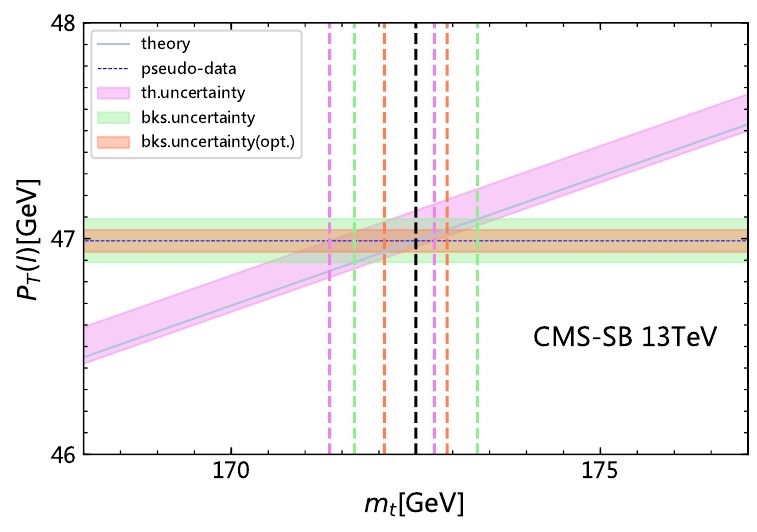
Figure 8 . Predictions on the average transverse momentum of the charged lepton of the signal process as a function of the top-quark mass (band along diagonal direction) and the projected mea- surement on the same quantity with only systematic errors from background modeling (horizontal bands). Extracted top-quark mass with various uncertainties are indicated by vertical